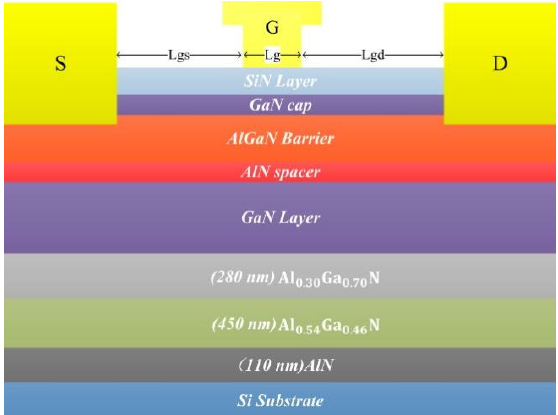
Figure 1. Schematic diagram of the overall structure of the device.